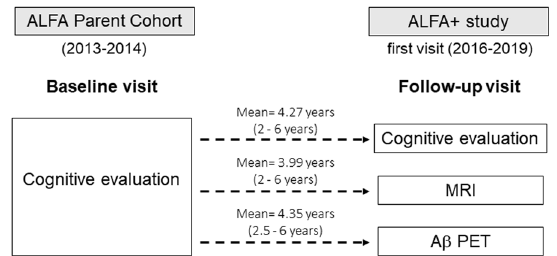
Fig. 1 Schematic representation of the time between baseline visit and follow‑up